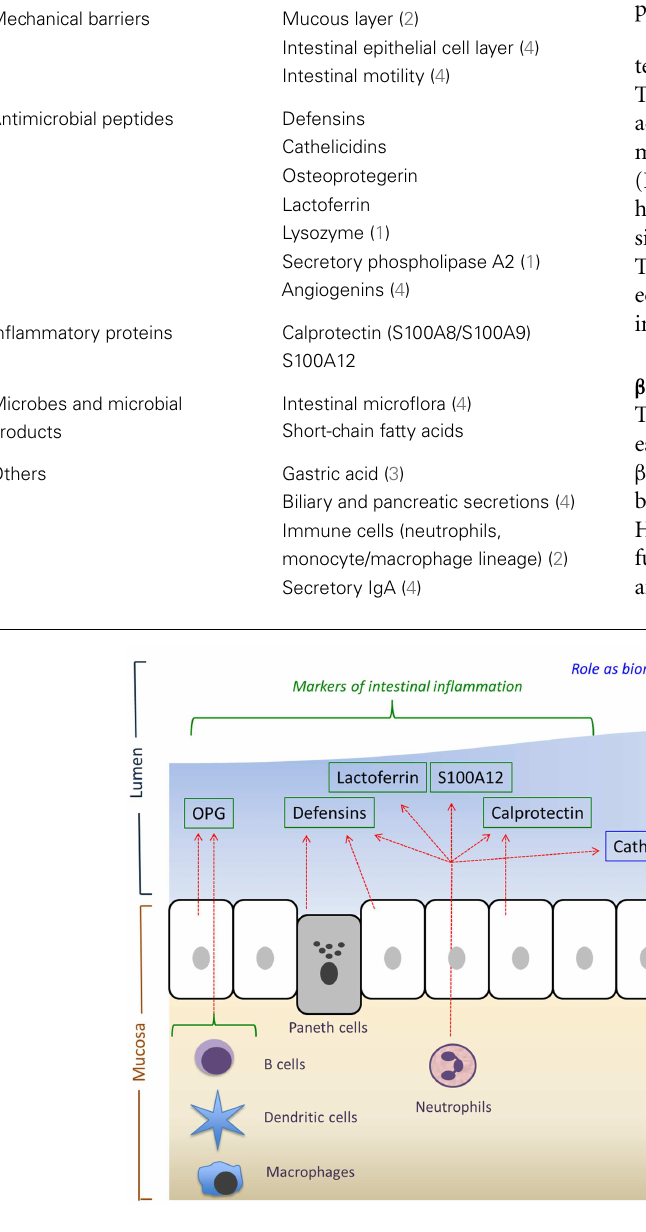
Table 1 | Components of the intestinal innate immune system.